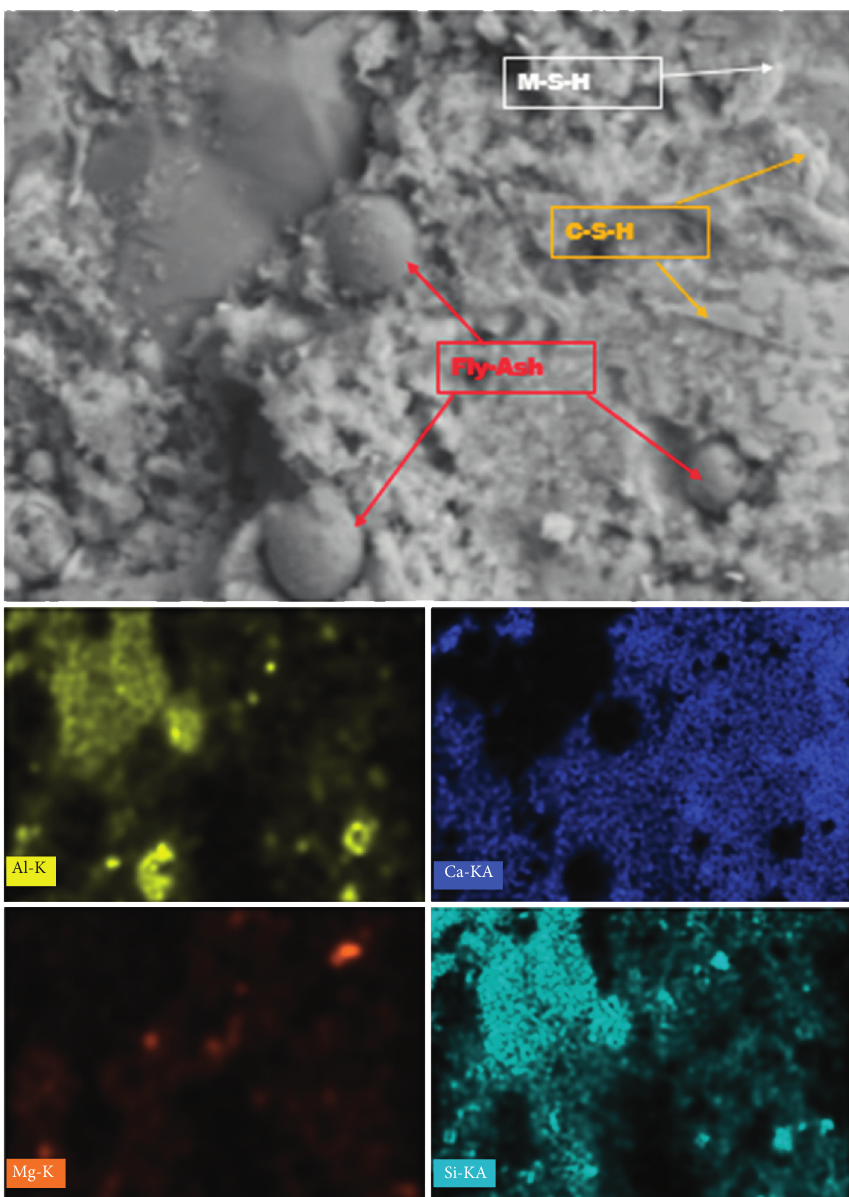
Figure 12: SEM and corresponding EDX mapping for Al, Ca, Mg, and Si in